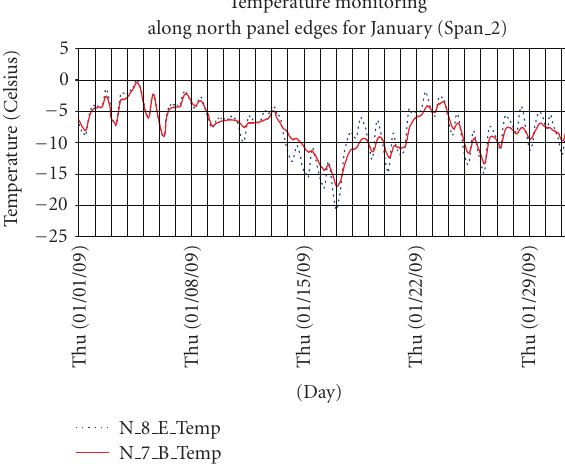
Figure 9: Temperature monitoring along north panel edge for span two